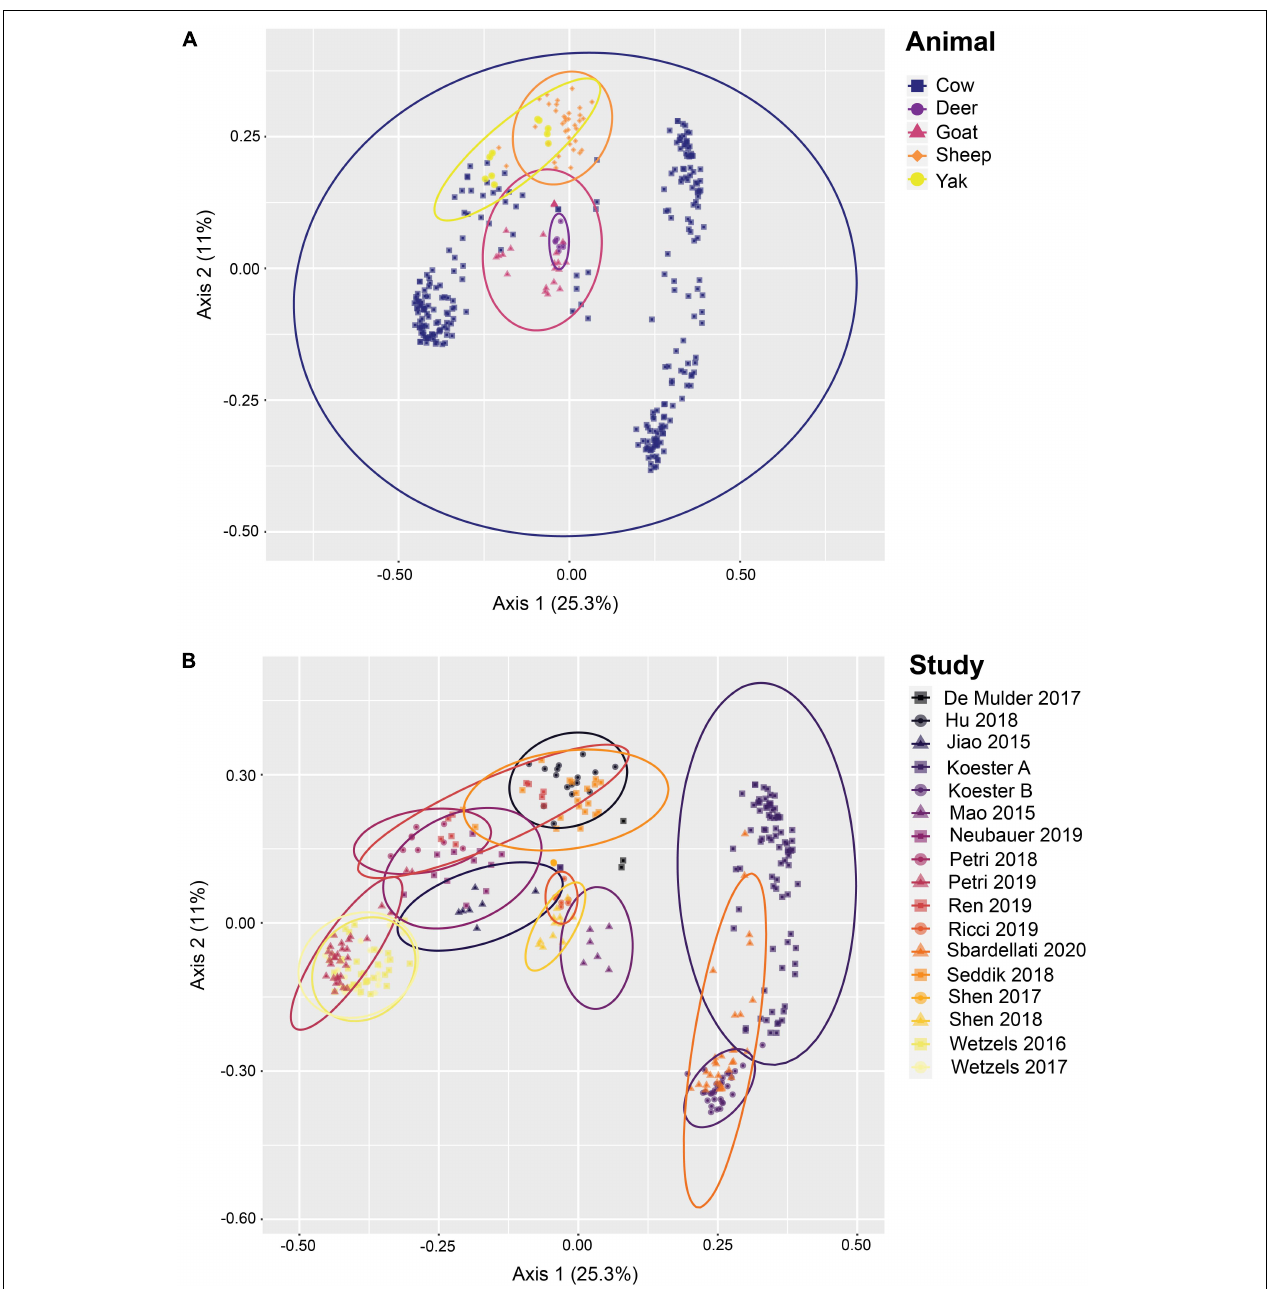
FIGURE 1 | Beta diversity of rumen epithelial microbial communities revealed by principle coordinates analysis based on Bray-Curtis distances after closed-reference OTU clustering. (A) Samples highlighted by animal, (B) shows samples highlighted by study. See Supplementary Table 1 for more details on the studies.